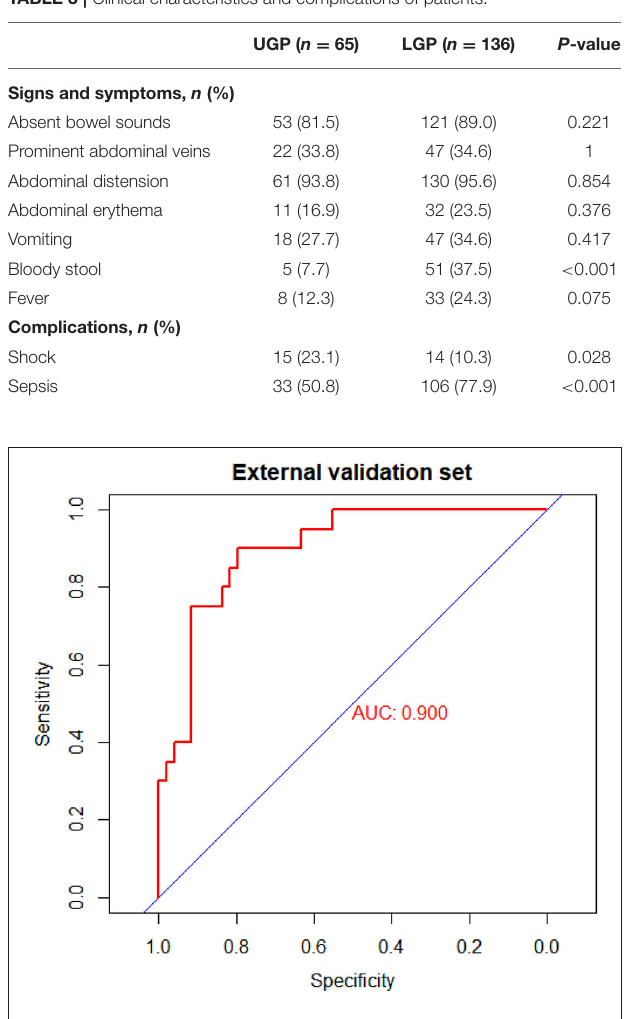
FIGURE 4 | Receiver operating characteristic (ROC) curves of the nomogram model in the validation cohort.